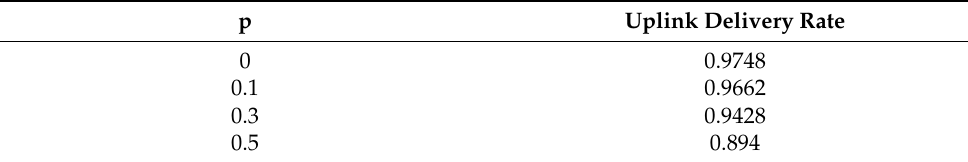
Table 11. Uplink response rate with Class C downlink interference.